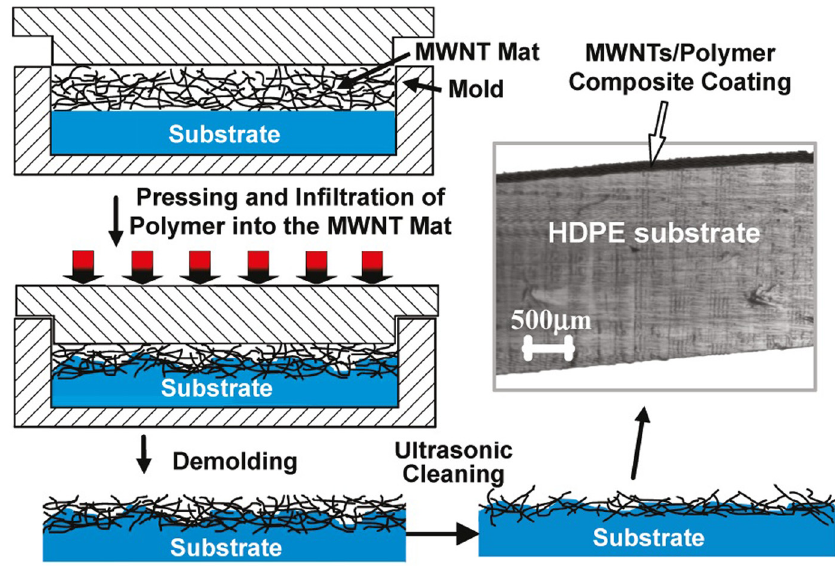
Figure 8: Scheme showing fabrication of SHPC and conductive MWCNTs/polymer composite coating. An optical image of the coated sample is also shown [ 126 ] . Reproduced with permission from ref. [ 126 ] ; © 2010 American Chemical